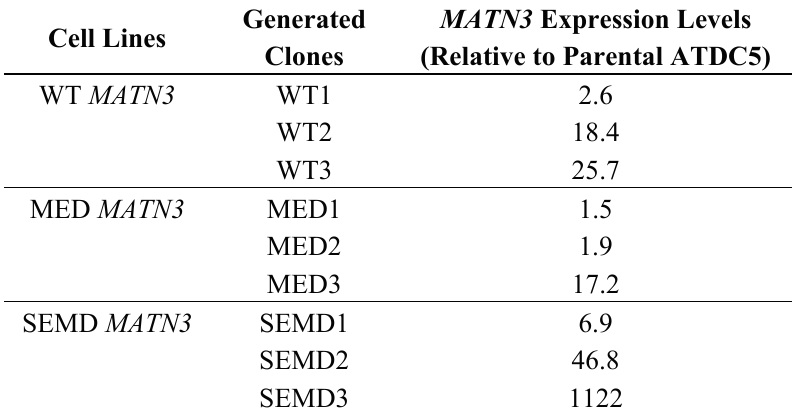
Table 1 . Wild-type or mutant MATN3 gene expression in stably transfected ATDC5 cell lines.